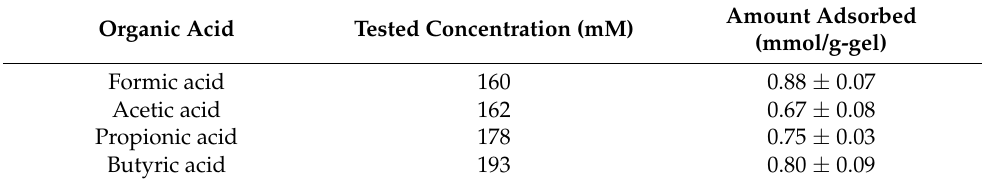
Amount Adsorbed (mmol/g-gel)